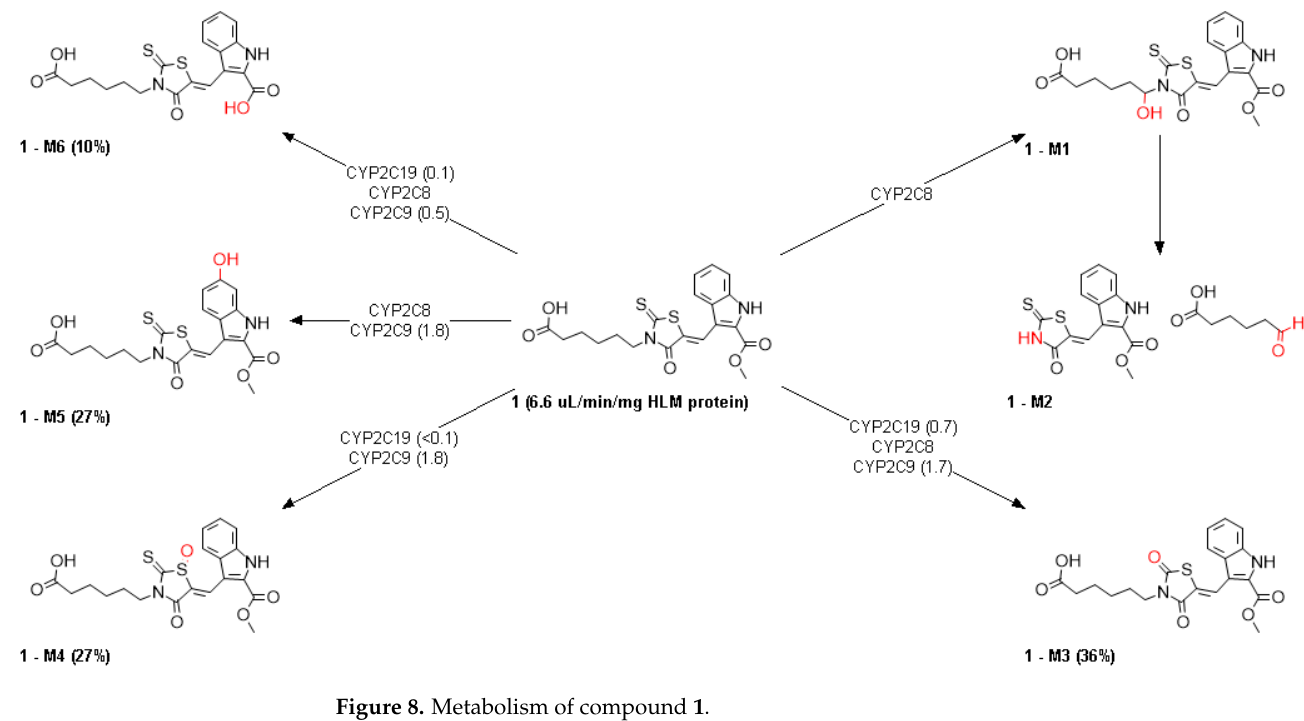
Figure 8. Metabolism of compound 1 .